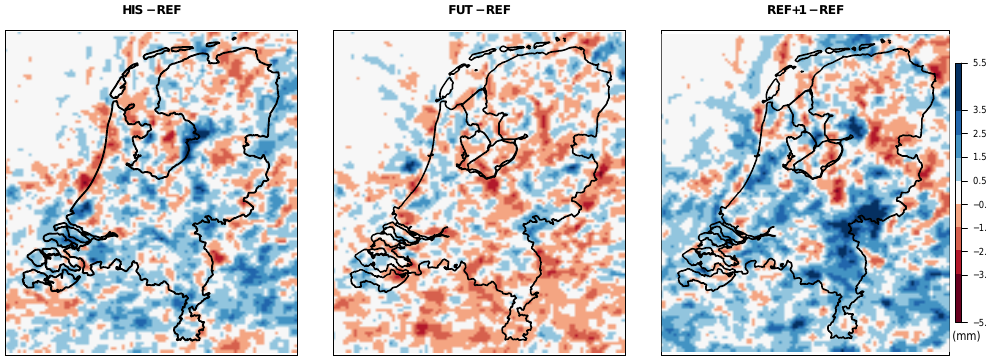
Figure 7. Spatial precipitation differences (mmday − 1 ) between the HIS, REF+1, and FUT experiments and the reference experiment.